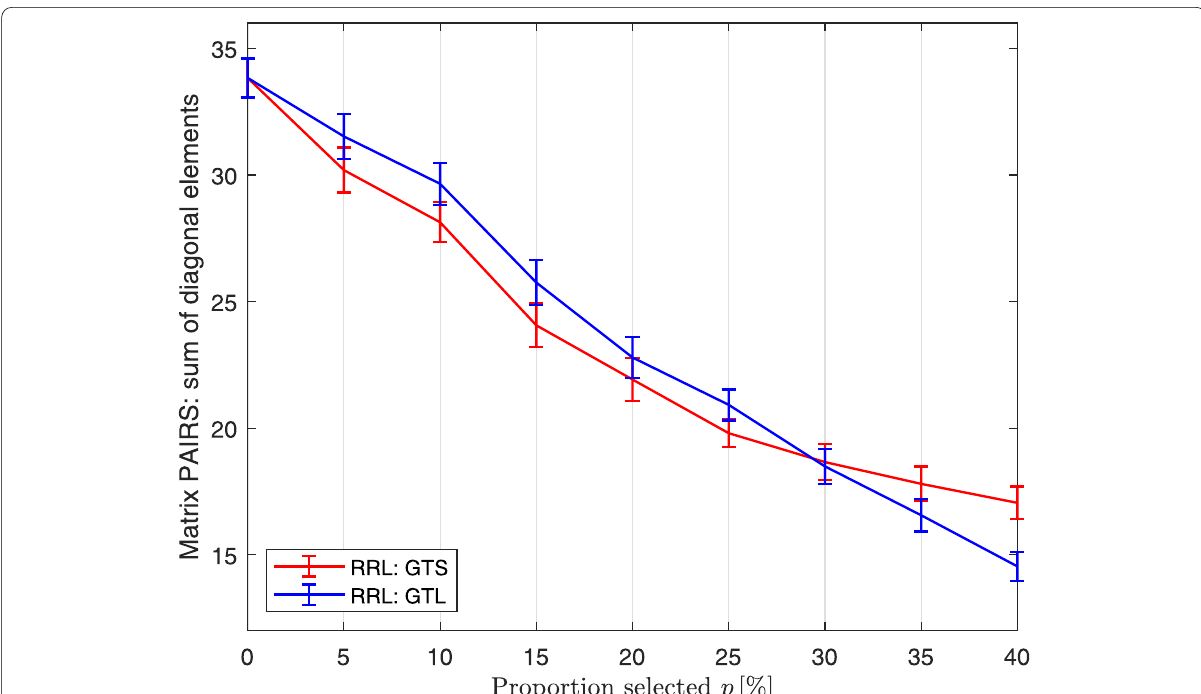
Fig. 2 The sum of diagonal elements of the PAIRS matrix (Y-axis) as a function of the genetic thinning intensity (0–40% ramets removed from the orchard, X -axis). The random reference line (RRL) is shown, i.e., the plot provides average values and 95% confidence intervals across 100 stochastic iterations. The ONA scenarios are not shown on the graph as the diagonal sum of PAIRS was always 0